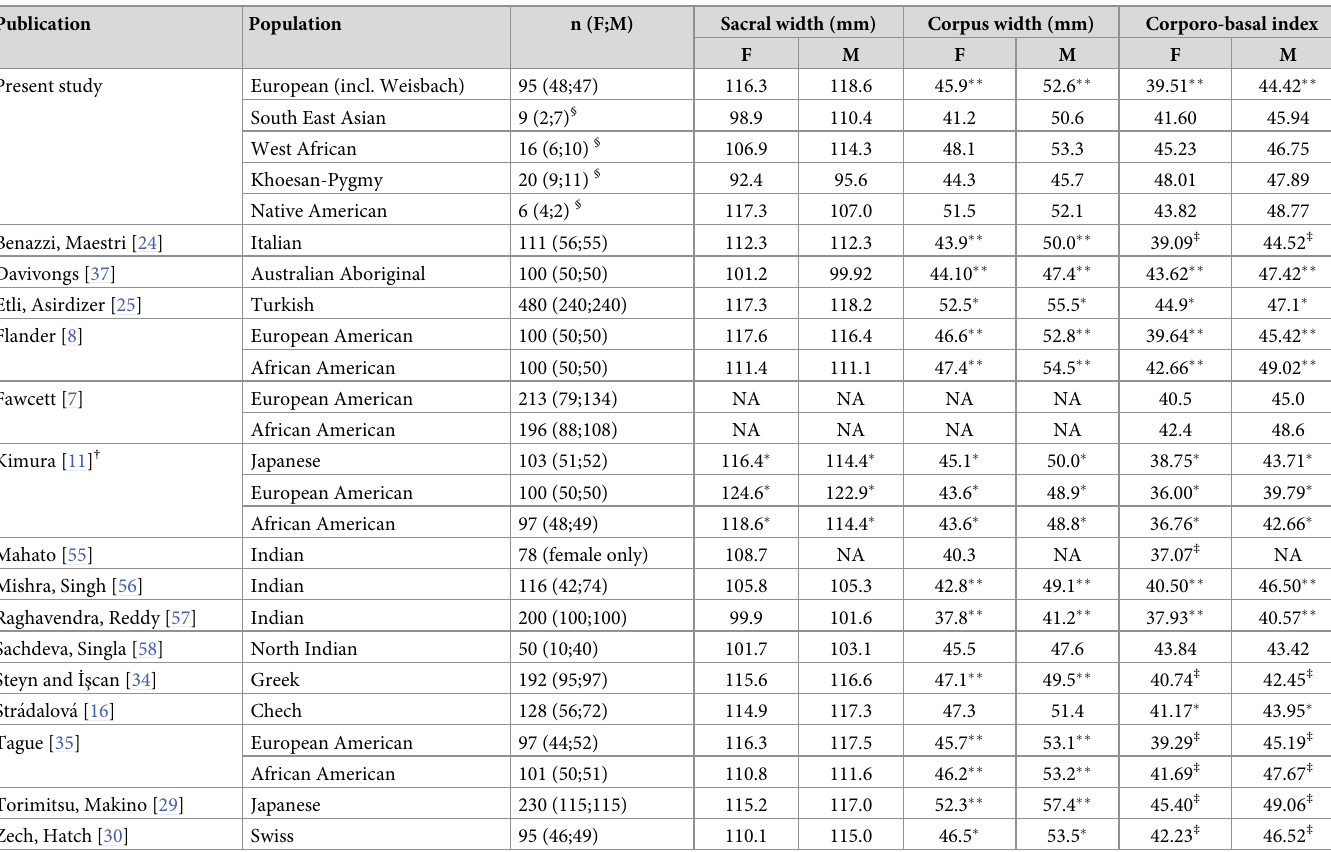
Table 5. Absolute measurements of sacral width, corpus width, and the associated corporo-basal index in this study compared to previously published mean